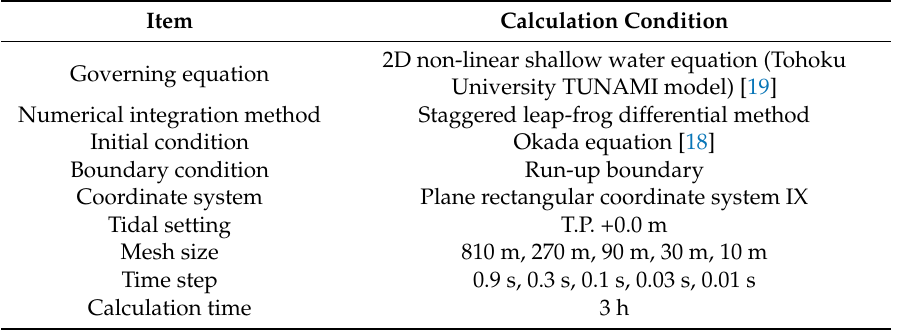
Table 9. Calculation conditions for the nonlinear longwave equation used in the tsunami numerical simulation for Soma.